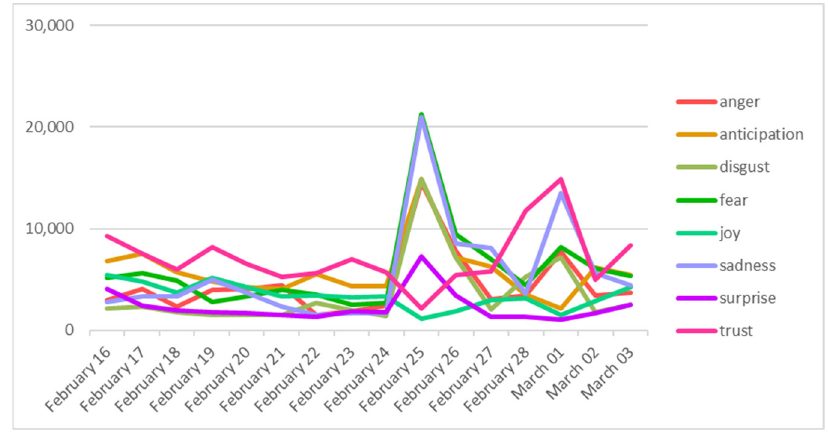
Figure 11. Daily evolution of sentiments.